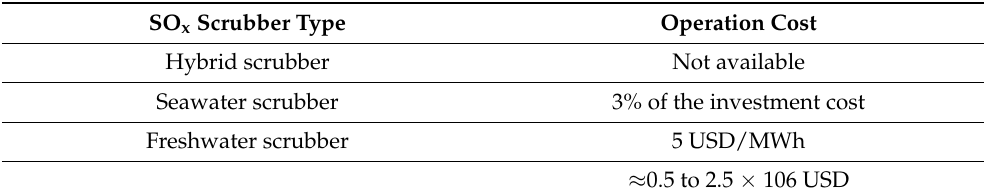
Table 8. Operation cost of three types of SO x scrubbers. The classification has been made based on the operational principle of each system. The values have been obtained from corresponding manufacturers of these systems. (Table was genuinely generated using data from refs. [32,36]).